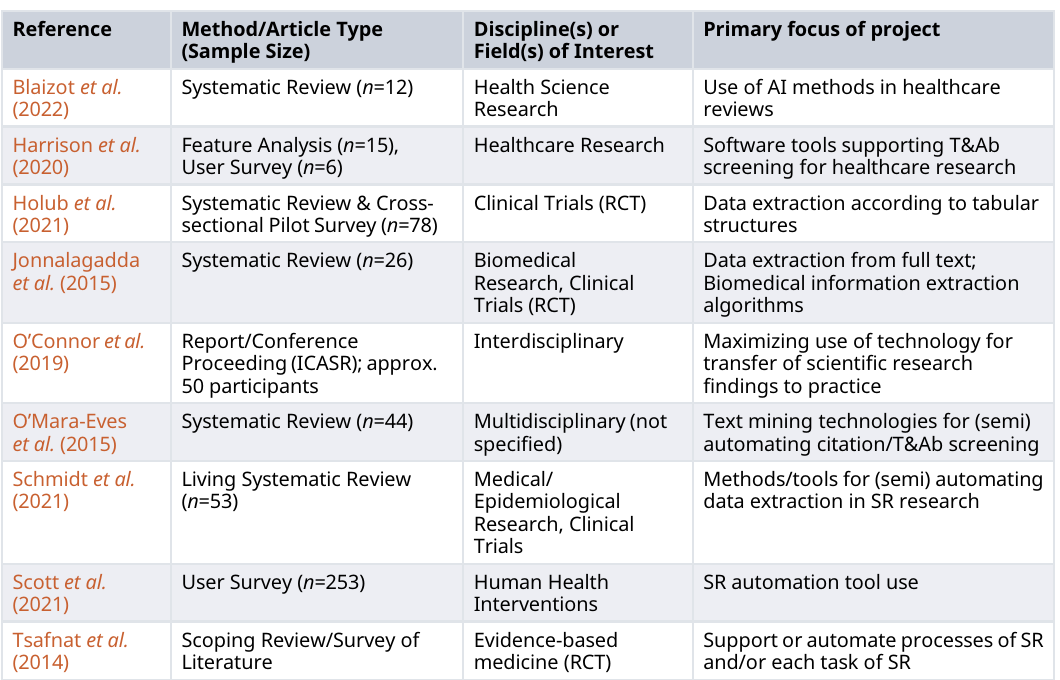
Table 1. Summary of existing